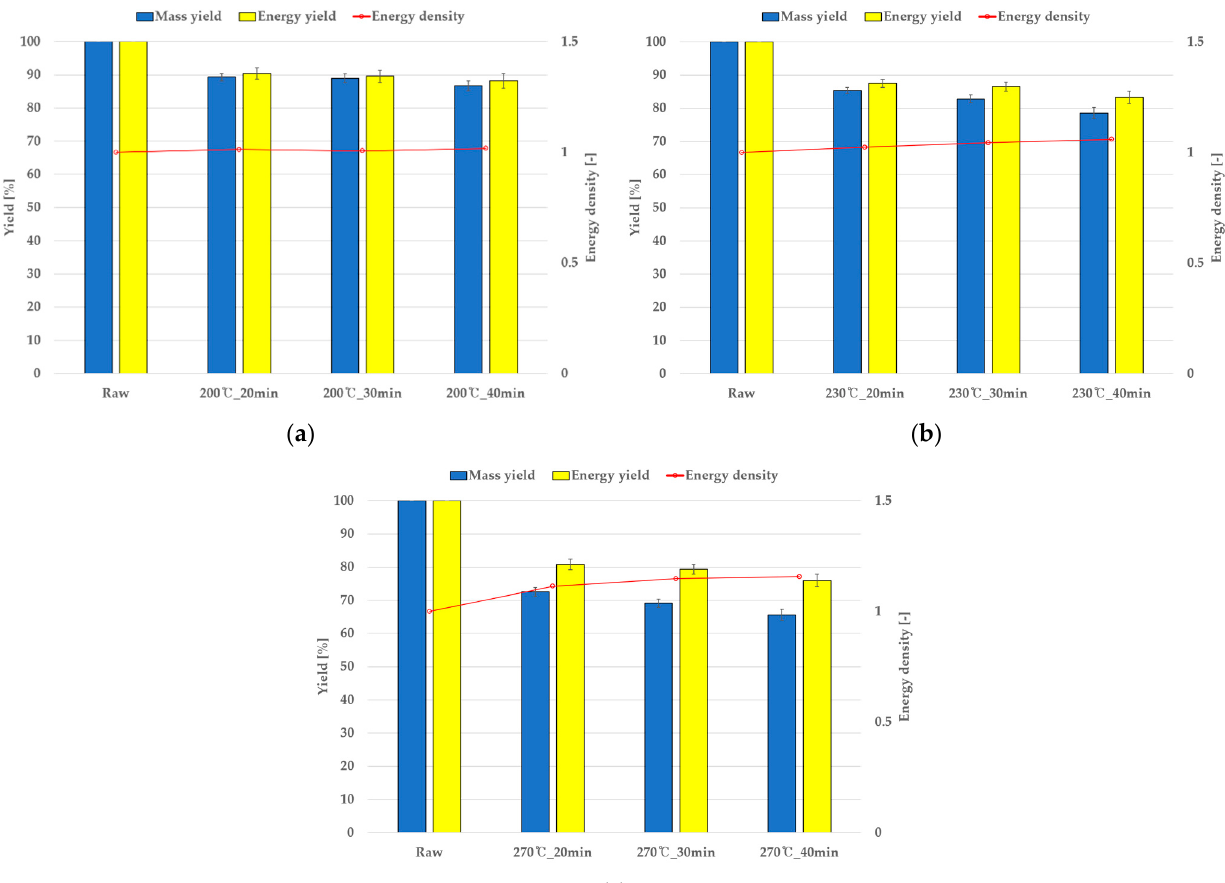
Figure 7. Perilla mass and energy yields and energy density according to torrefaction process time and temperature. ( a ) At 200 °C, ( b ) at 230 °C, and ( c ) at 270 °C.